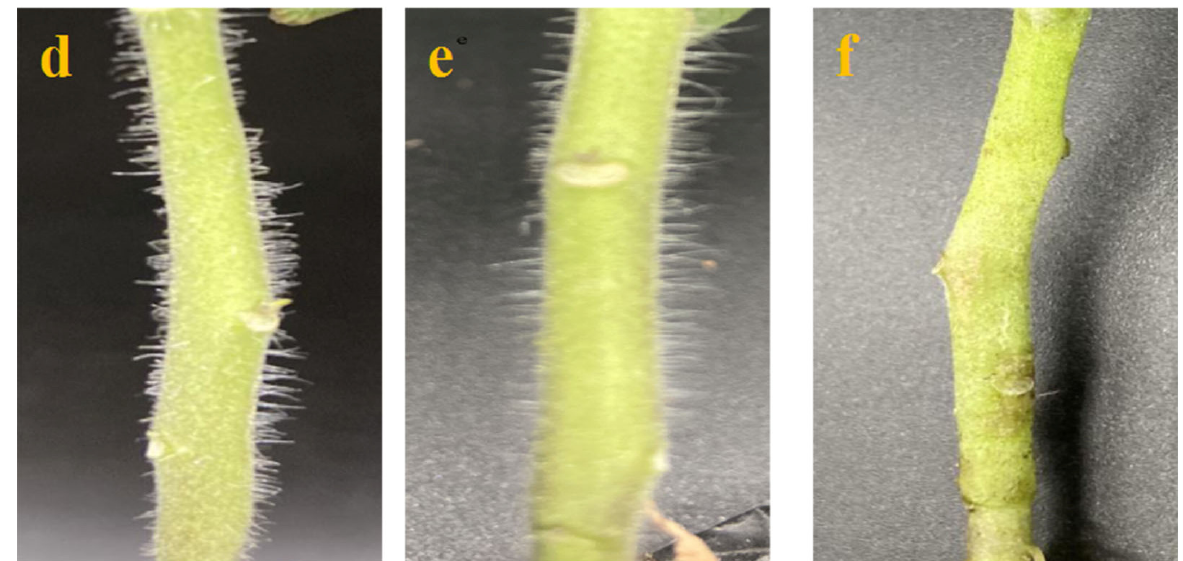
Figure 1. Results of inoculation. ( a – c ) ‘Moneymaker’ inoculated with FORL ( Fusarium oxysporum f. sp. radicis-lycopersici ) at 0, 3, and 6 dpi; ( d – f ) ‘19912’ inoculated with FORL at 0, 3, and 6 dpi. 2.2. Microscopic Analysis of FORL Growth in Two Tomato Cultivars